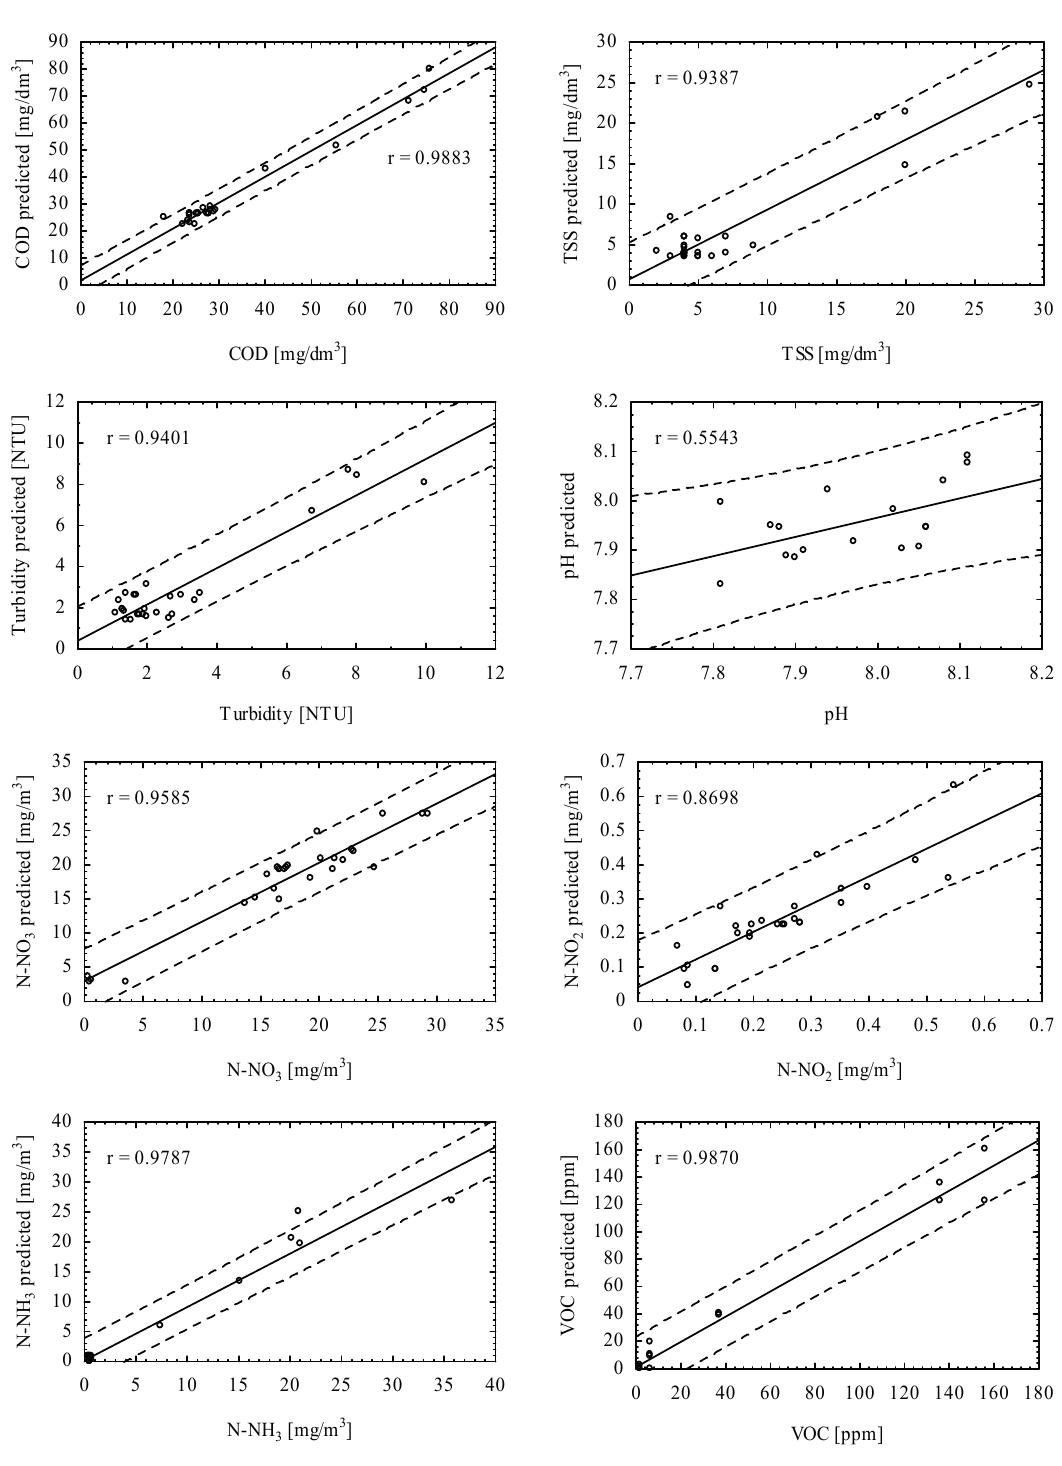
Figure 6. Correlation and confidence interval (0.95) between measured parameters and those predicted for validation subsets using e-nose: COD, TSS, turbidity, pH, N-NO 3 , N-NO 2 , N-NH 3 ,